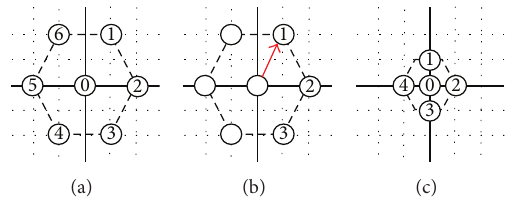
Figure 16: The definition of directions in gene on